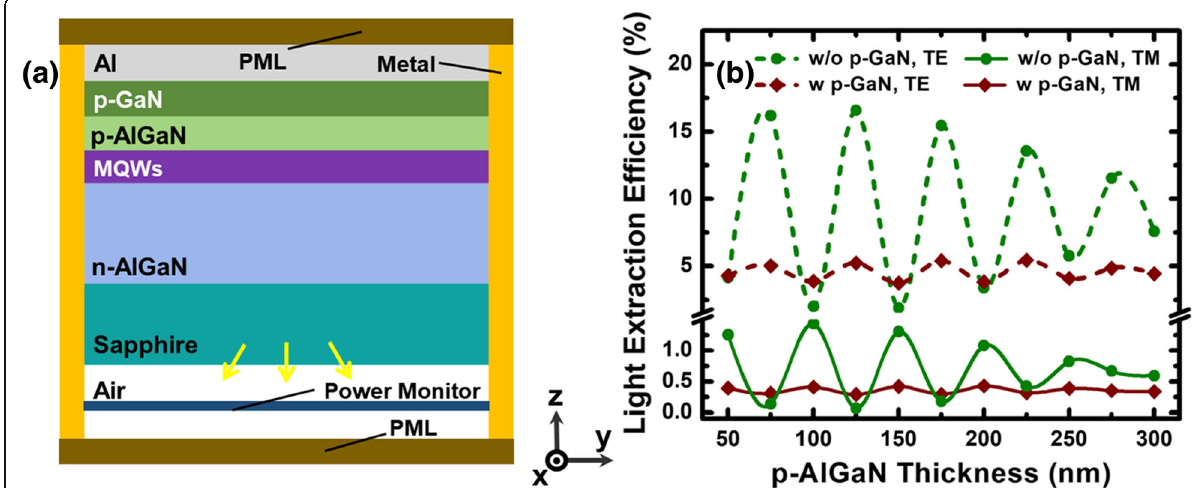
Fig. 1 a Schematic side view diagram of 3D FDTD computational models for conventional flip-chip DUV LED structure. b TE- and TM-polarized LEEs for DUV LED with p-GaN and without p-GaN as a function of the p-AlGaN